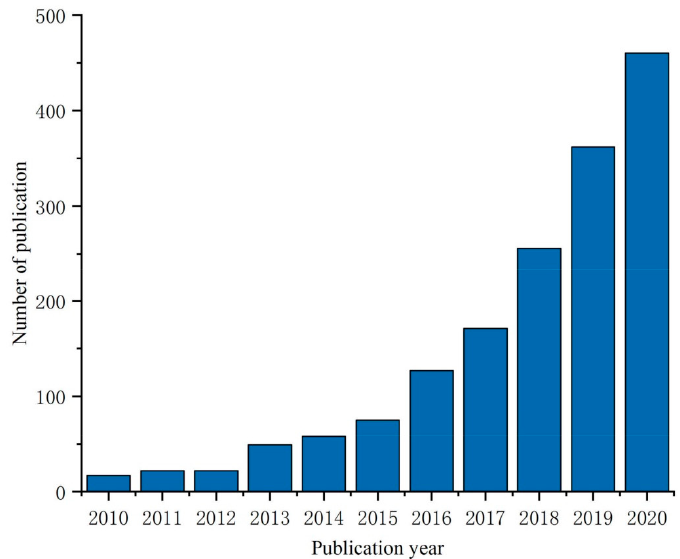
Figure 1. The stability approach and main application of cellulose-based porous materials.